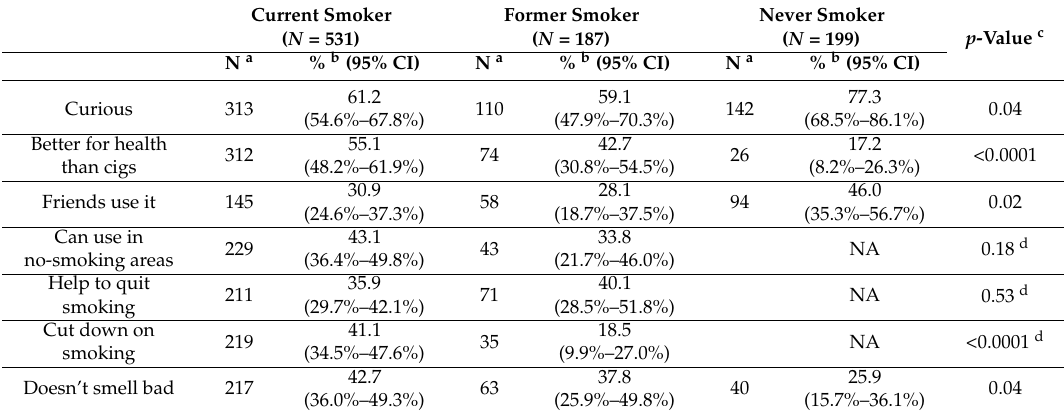
Table 2. Percent endorsing various reasons for trying electronic cigarettes by smoking